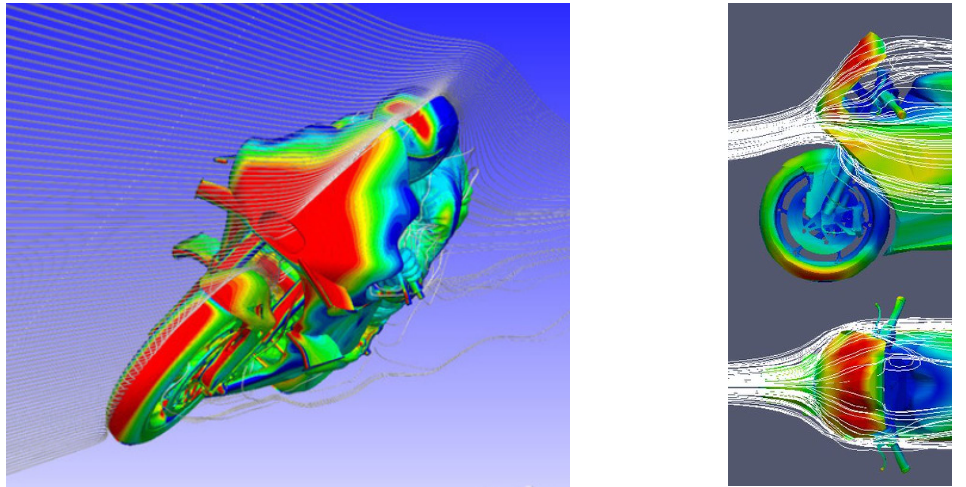
Figure 4. Example of motorcycle Computational Fluid Dynamics (CFD) simulations, useful for both front and rear tires convection